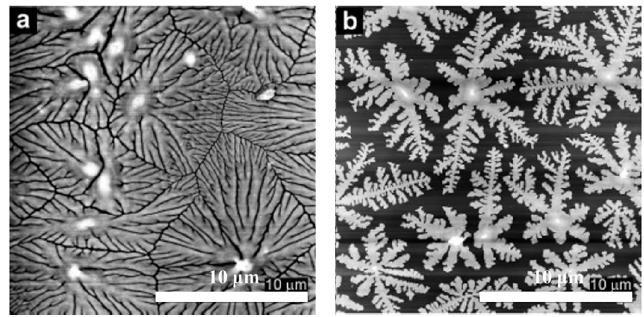
Figure 3. TM-AFM height images of PCL thin films crystallized at room temperature on the carbon-coated substrates at a film thickness of ( a ) 15 and ( b ) 6 nm [61]. Scale bar: 10 μ m. Copyright 2005. Reproduced with permission from the American Chemical Society.